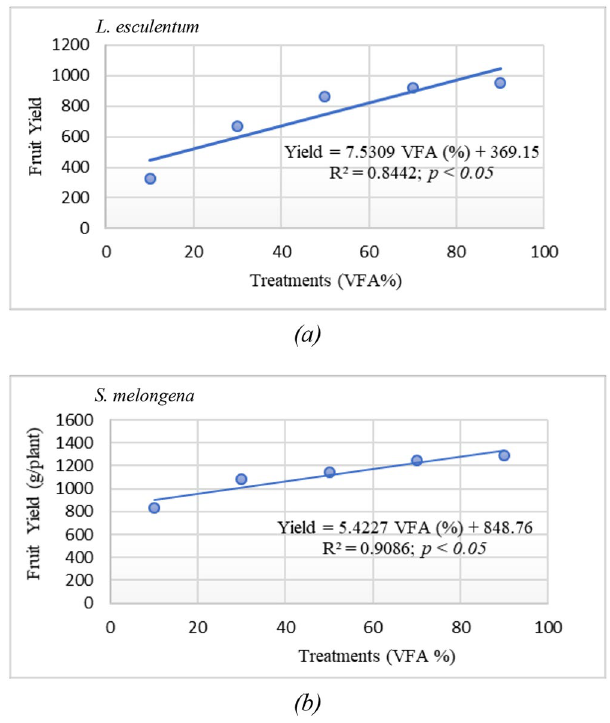
Figure 6. The relationship between vermicomposted fly ash concentrations incorporated in soil and yield of Lycopersicon esculentum and Solanum melongena respectively.